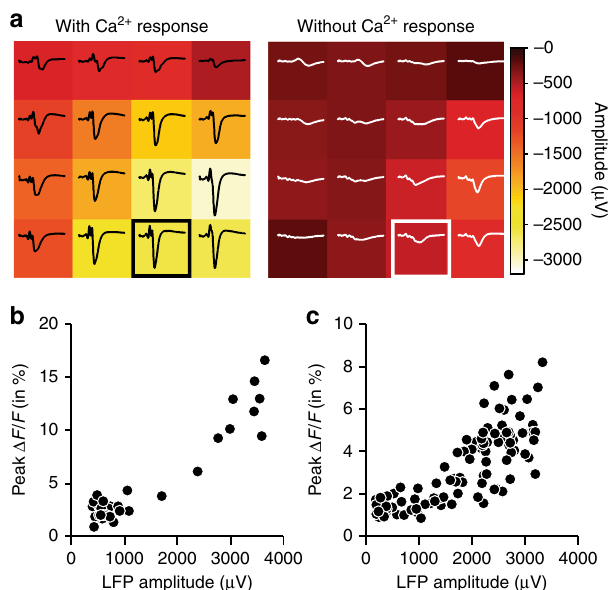
Fig. 4 Relationship between local fi eld potential (LFP) and Ca 2 + transients. a Comparison of LFP amplitudes across the array in trials where Ca 2 + transients were observed (left; 10 trials) or not observed (right; 13 trials, only trials with LFP response amplitudes < − 500 µ V are included); amplitudes (heatmap) and traces are trial averages; channel 15 (where Ca 2 + data was acquired) is highlighted. Data from experiment shown in Fig. 3c – e. b , c Correlation between LFP and Ca 2 + peak amplitude per trial; trials with LFP responses < − 400 µ V are included. Calcium signal amplitudes are derived from two different animals; representative experimental data for b (37 trials included) is shown in Fig. 3, representative data for c (100 trials included) is shown in Supplementary Fig. activity, we used a single electrical pulse (300 μ s, 1 mA) delivered to the contralateral whisker pad. Fields-of-view (FOVs) of ~ 50 μ m × 100 μ m were imaged at ~ 10 Hz in frame-scan mode. Each FOV, including multiple neuronal cell bodies, was imaged con- tinuously for ~ 250 s. During this time, we delivered 50 stimuli at an interval of 5 s. An example FOV is shown in Fig. 3c; neuronal cell bodies (labeled n1 – n7) are brighter than the surrounding neuropil; the FOV also contains a vessel (black) with adjacent astrocyte labeled both with OGB1 and SR101 (yellow). Stimulus- induced calcium increases were observed in neuronal cell bodies and neuropil for some of the stimulus trials (labeled by asterisks in Fig. 3d; recordings of all six trials in Supplementary Movie 1).